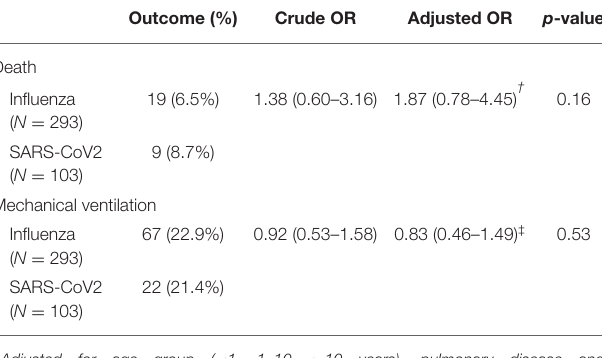
TABLE 4 | Crude and adjusted estimates of the odds ratio for in-hospital death and mechanical ventilation estimated by logistic regression among patients with symptomatic SARS-CoV2 infection in comparison to patients with symptomatic